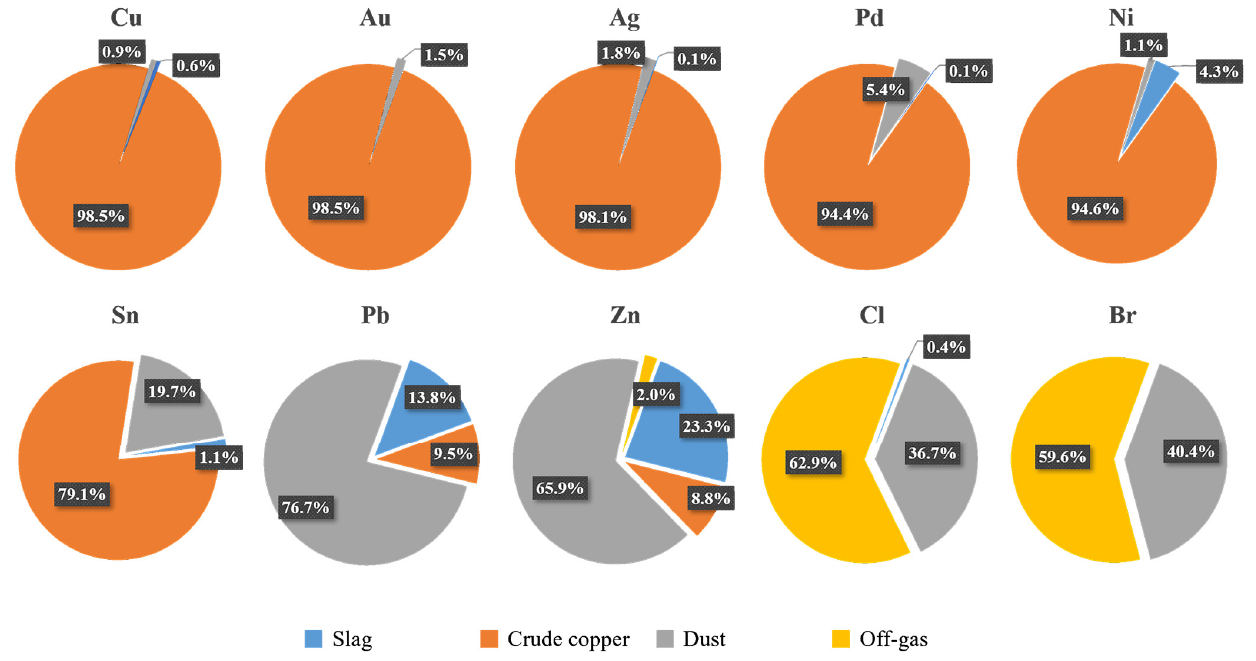
Figure 2. The distribution behaviors of Cu, Au, Ag, Pd, Ni, Sn, Pb, Zn, Cl, and Br.